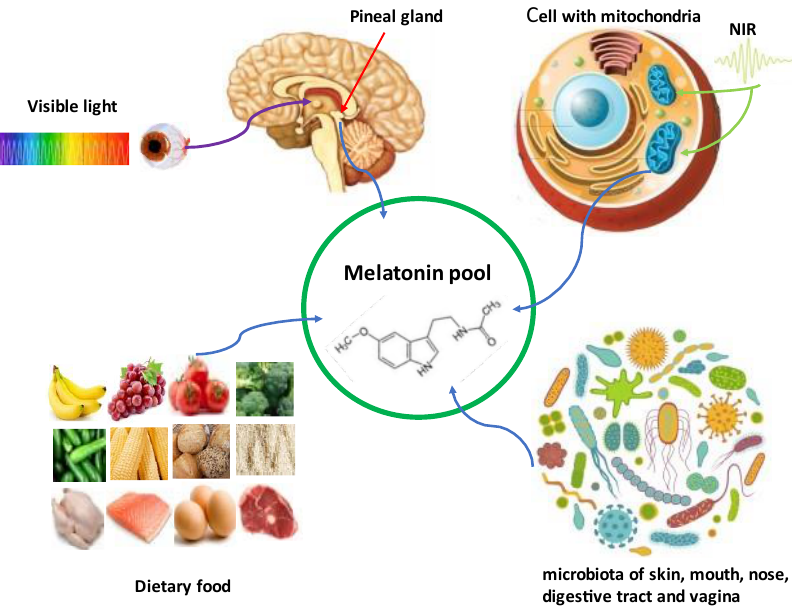
Figure 4. Illustration of the melatonin pool of vertebrates. NIR: near infrared radiation.